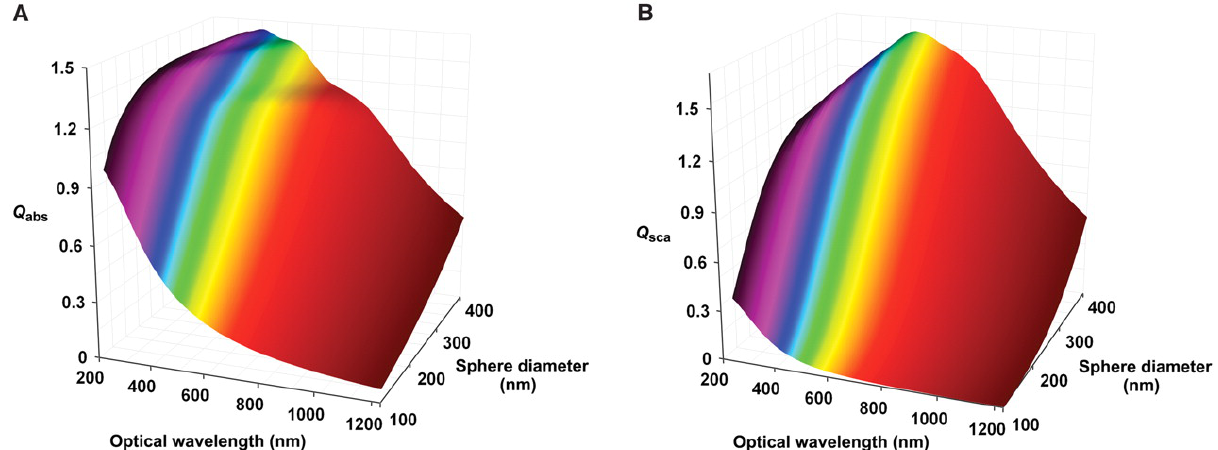
Fig. 36. Diameter and optical wavelength dependence of the light absorbing and scattering efficiencies, Q abs (A) and Q sca (B) , of the carbon spheres observed by Alexander et al. (2008). The plots are colored to match the colors of the optical wavelengths; darkening of the red at high wavelengths and of the violet at low wavelengths represent infrared and ultraviolet, respectively (from Alexander et al., 2008, copyright 2008 by the American Association for the Advancement of Science, reproduced with